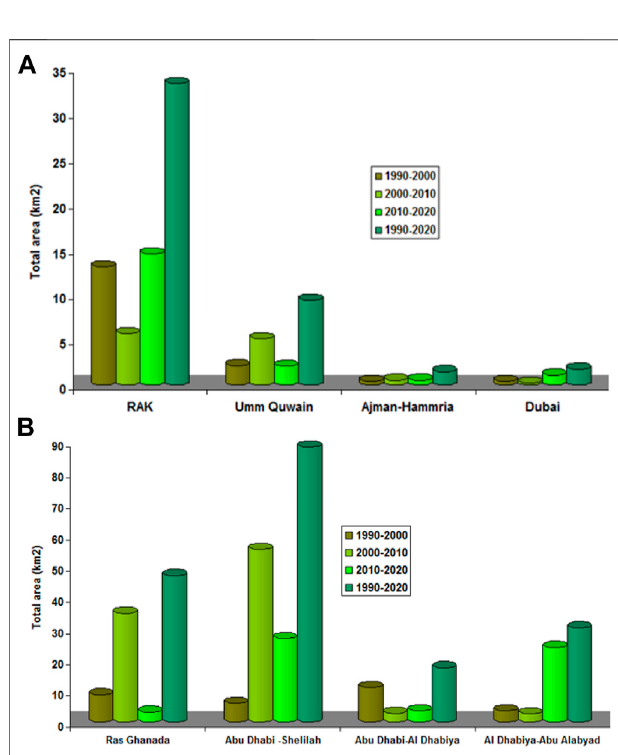
FIGURE 13 | Graphical representation of the mangrove forests of the NUAE forests (A) and Abu Dhabi extent from 1990 to 2020 (in km 2 ).